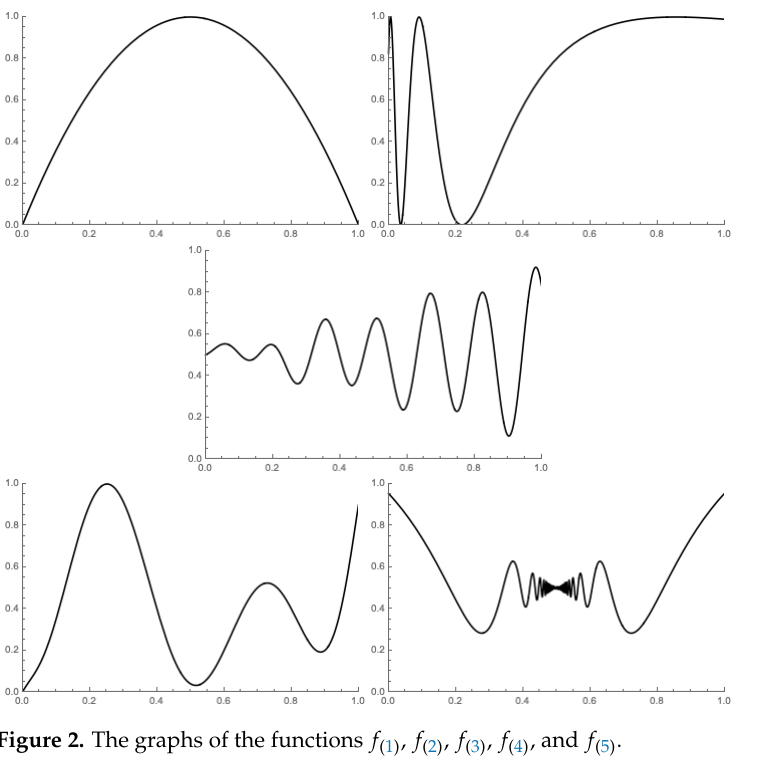
Figure 2. The graphs of the functions f 1 , f 2 , f 3 , f 4 , and f 5 .